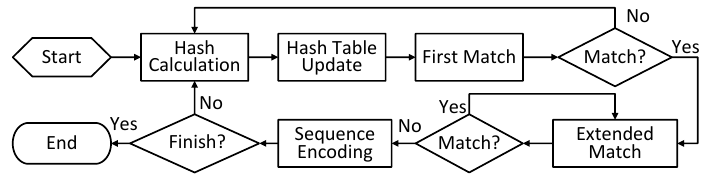
Figure 3. The LZ4